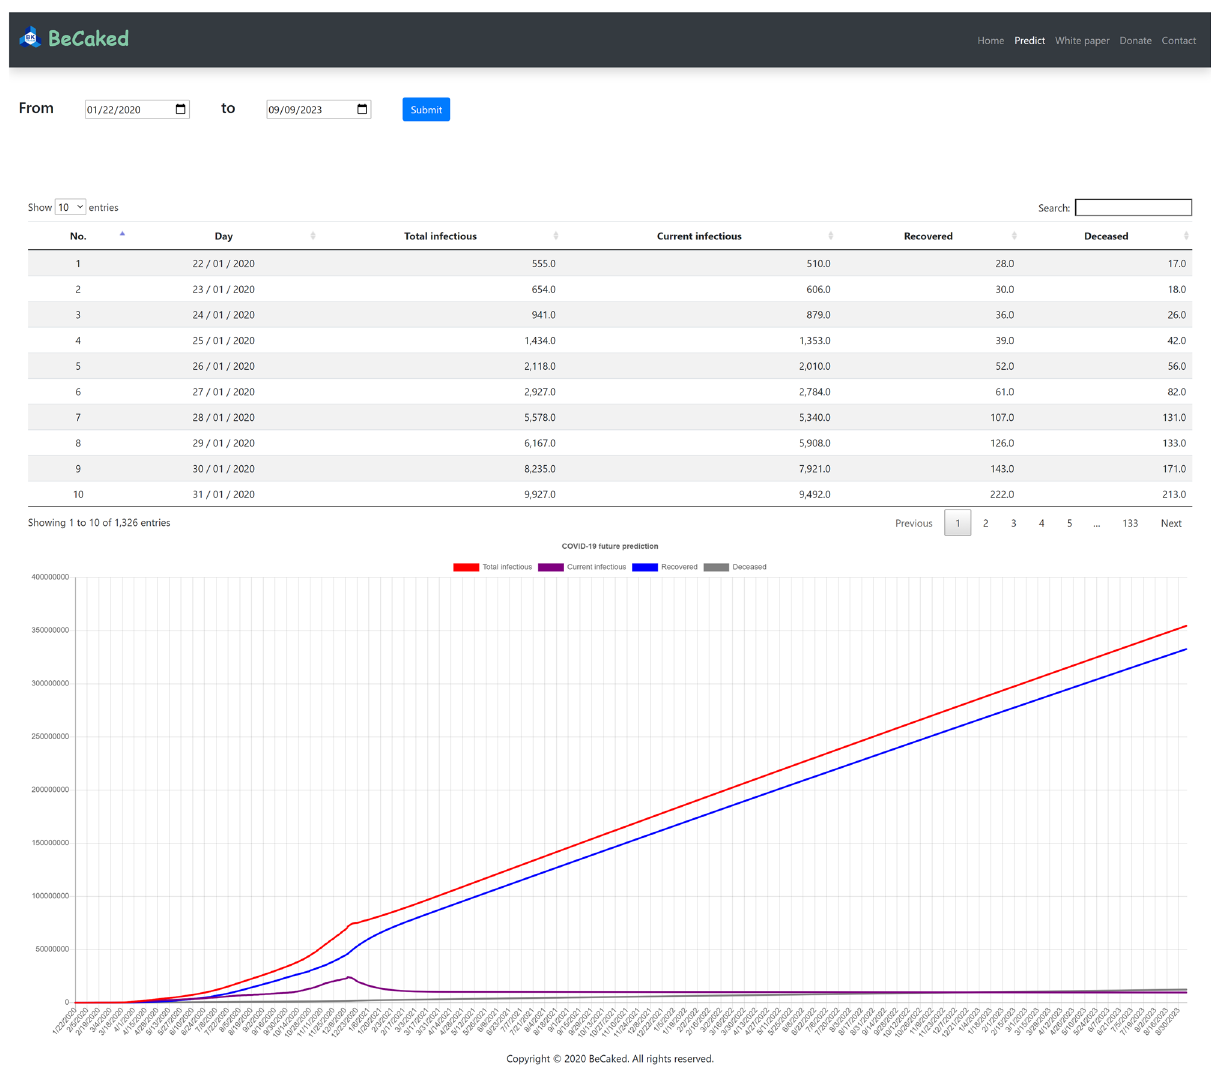
Figure 15. Long-time forecasting